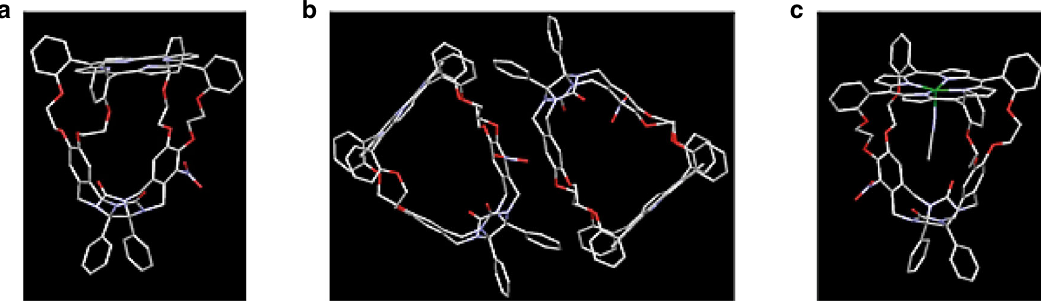
Fig. 3 X-ray structures of enantiopure cage compounds. a X-Ray structure of ( − )- R p -( S , R )- 1 . b View showing the arrangement of the enantiomeric molecules in the crystal of ( − )- R p -( S , R )- 1 . c X-Ray structure of ( + )- S p - ( R , S )- 3 with an acetonitrile molecule inside the cage. Color codes: oxygen, red; nitrogen, purple; carbon, gray; and zinc, green. Hydrogen atoms have been omitted for clarity.